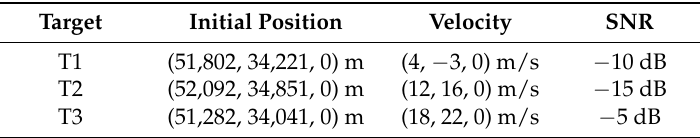
Table 3. Moving target parameters for Sections 5.2 and 5.3.